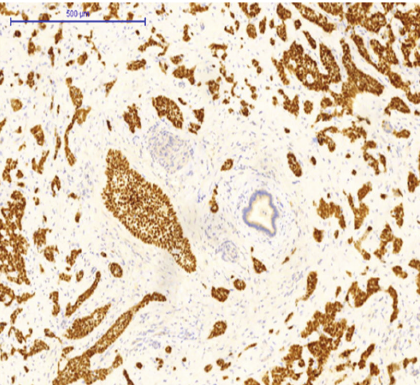
Figure 8: CK7 immunohistochemical staining. The benign bile duct in the center is positive. Some tumor cells show a faint to moderate reaction, whereas other tumor cells are completely